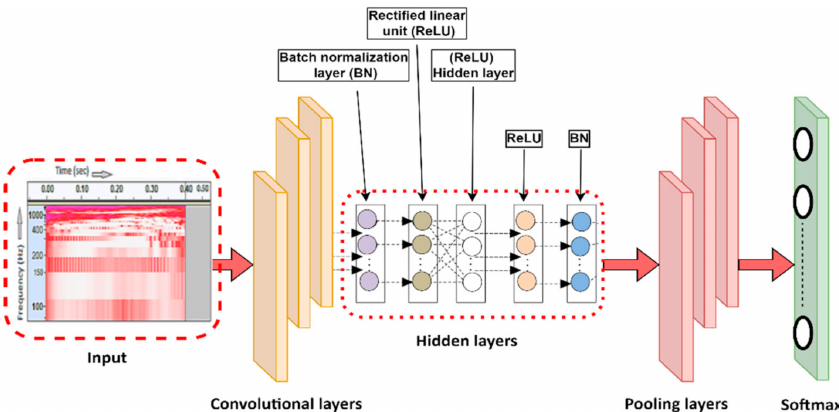
Figure 2. Diagram of the proposed NIN architecture of the neural network.